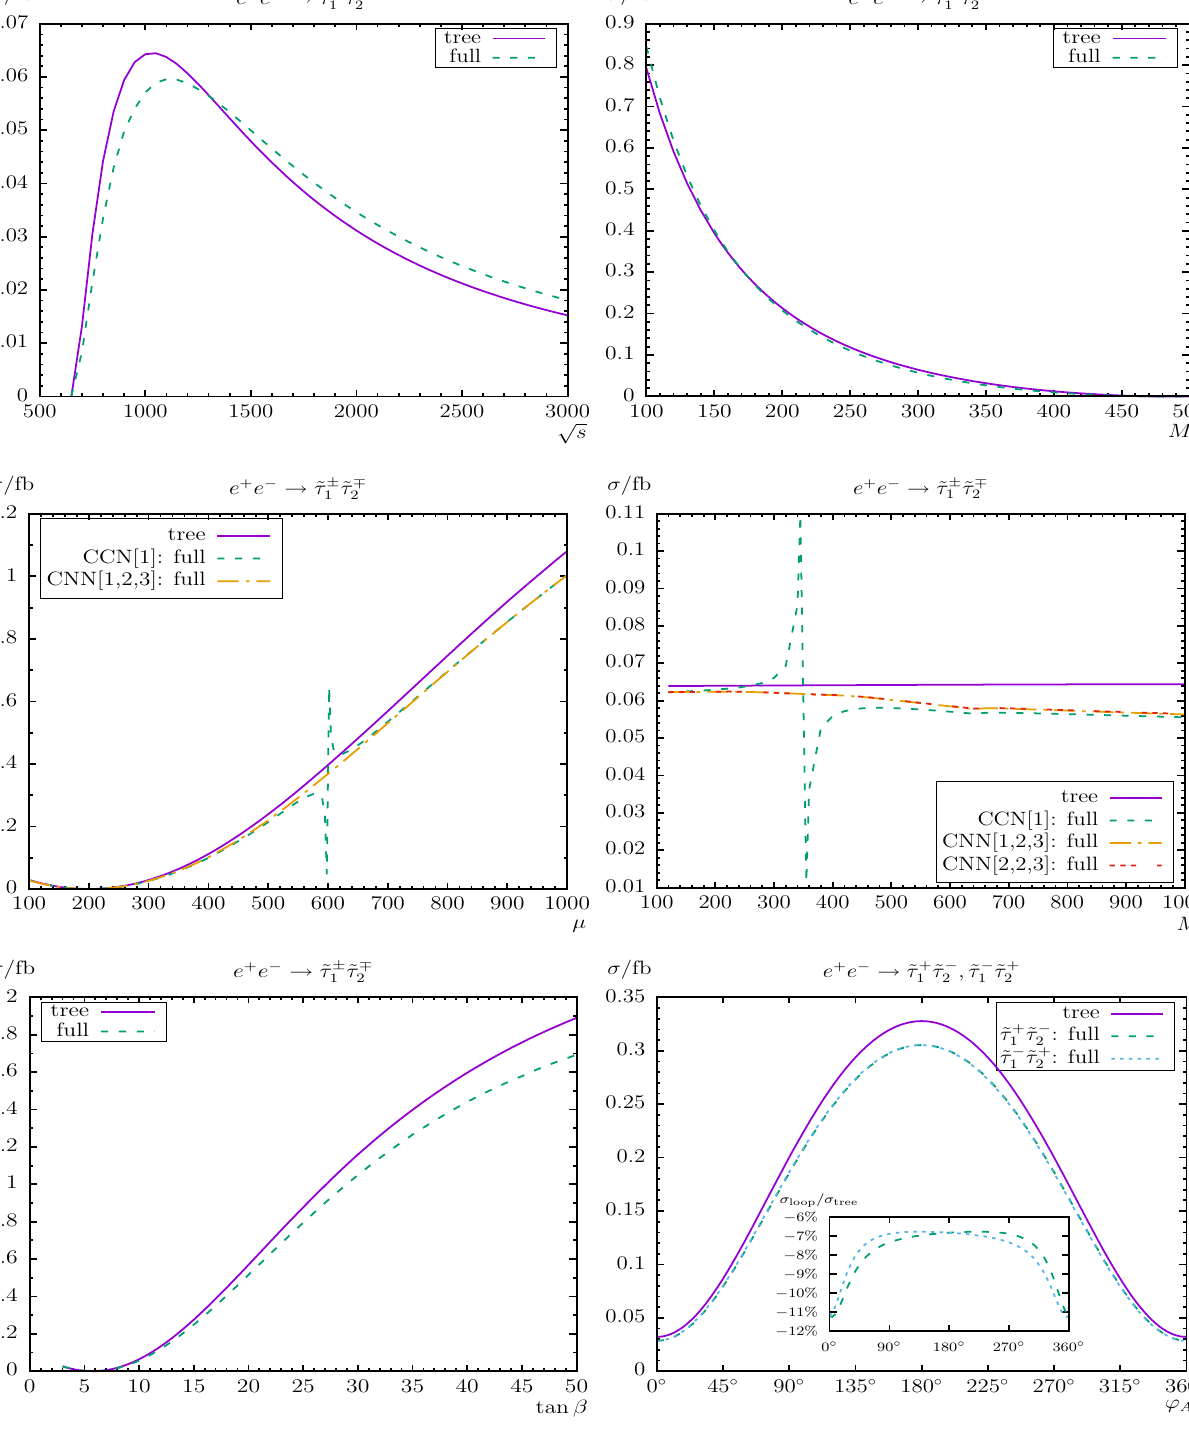
M ˜ (right) varied; the middle plots show μ (left) and M 2 (right) varied; E the lower plots show t β (left) and ϕ A √ s (left) and energies are in